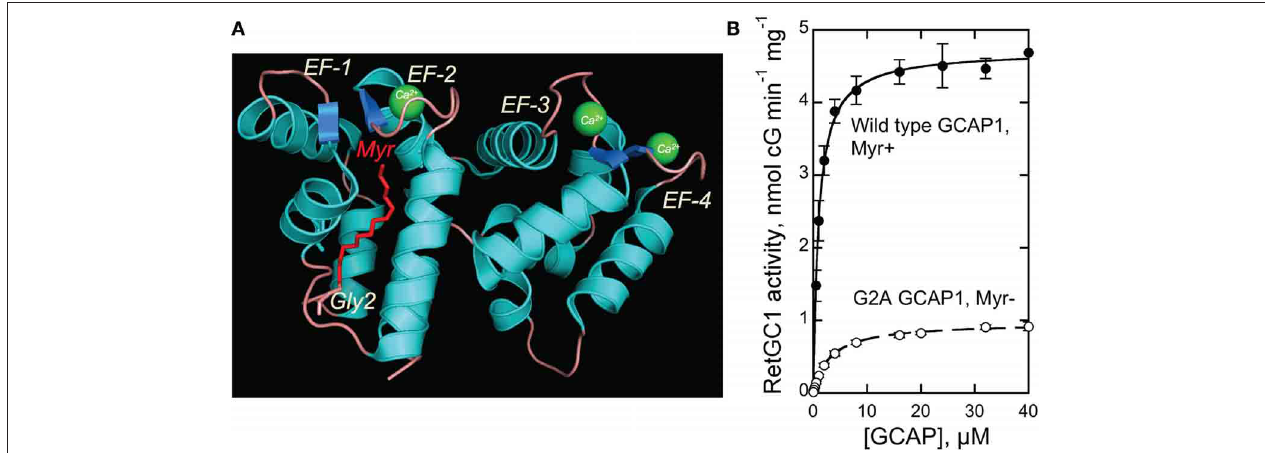
FIGURE 1 | (A) Structure of myristoylated GCAP1 [Stephen et al. (2007)]. Myristoyl residue buried inside the EF-1/EF-2 pair of EF-hands is shown in red . (B) Dose-dependence of recombinant RetGC1 activation by myristoylated and G2A GCAP1 (mean ± SD). For details of the assay—see Materials and